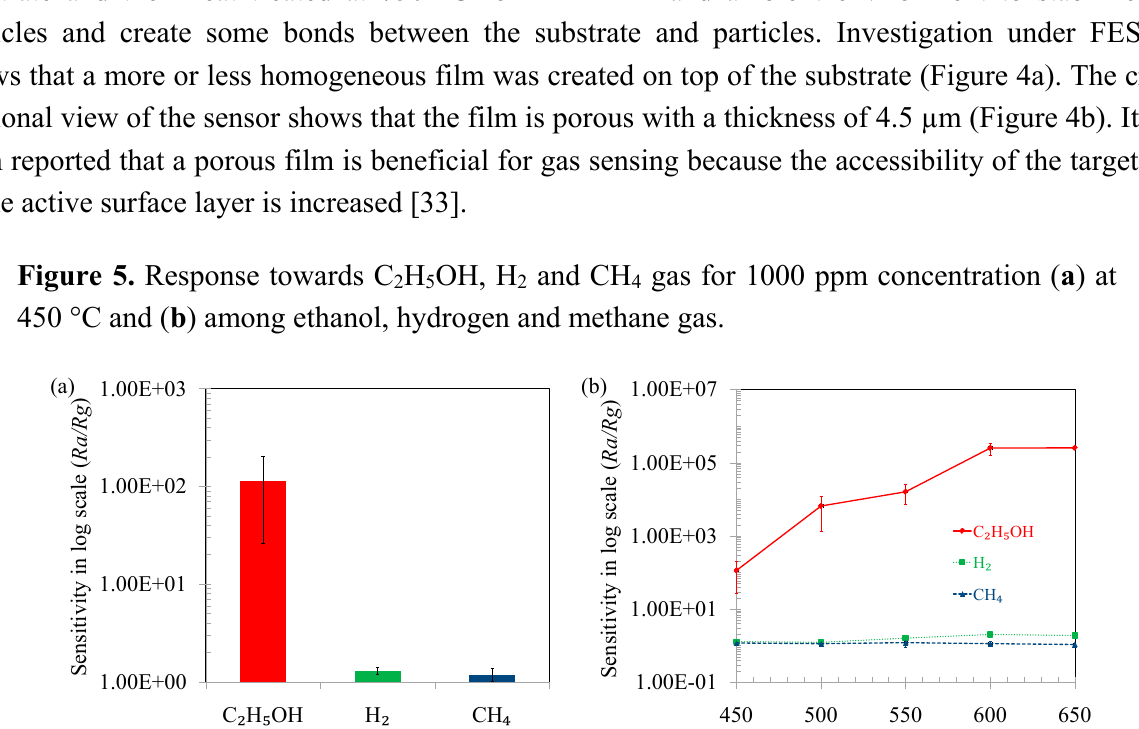
H OH, H and CH gas for 1000 ppm concentration ( a ) at 2 5 2 4